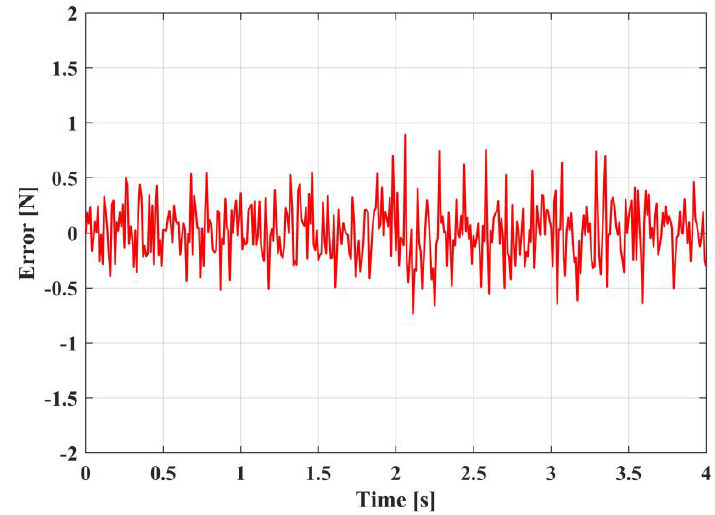
Figure 24. The contact force errors.